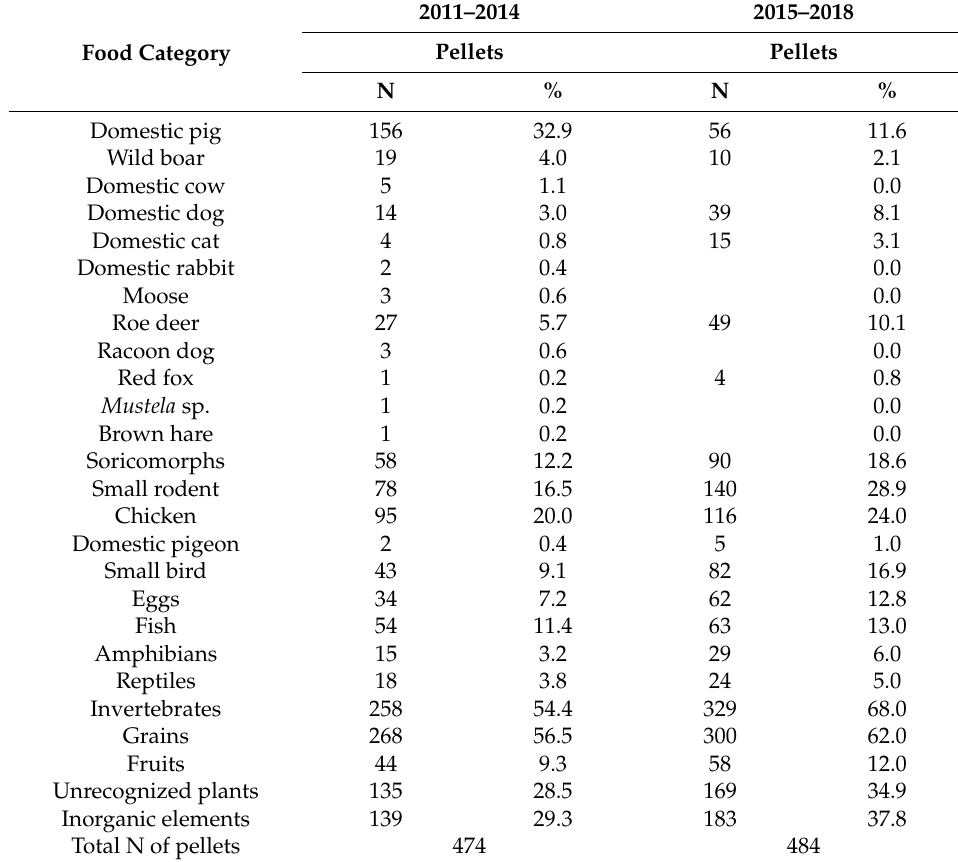
Table 2. Dietary composition of ravens in Central Poland in the two (‘pre ASF’ and ‘ASF outbreak’) periods on the basis of pellet